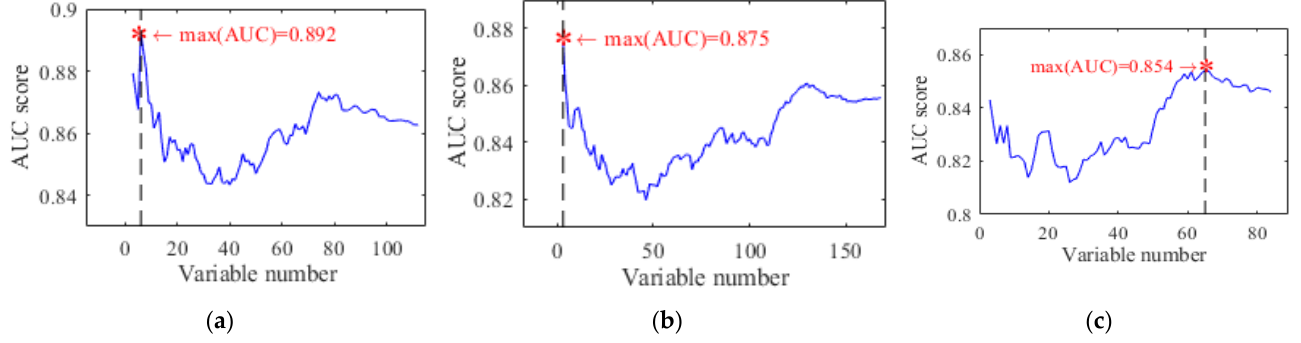
Figure 8. The trends of three AUC score curves of polyp classification, their maximums and their partitions over 63 polyps via forward step feature selection method: ( a ) D1, ( b ) D2, and ( c ) D3.